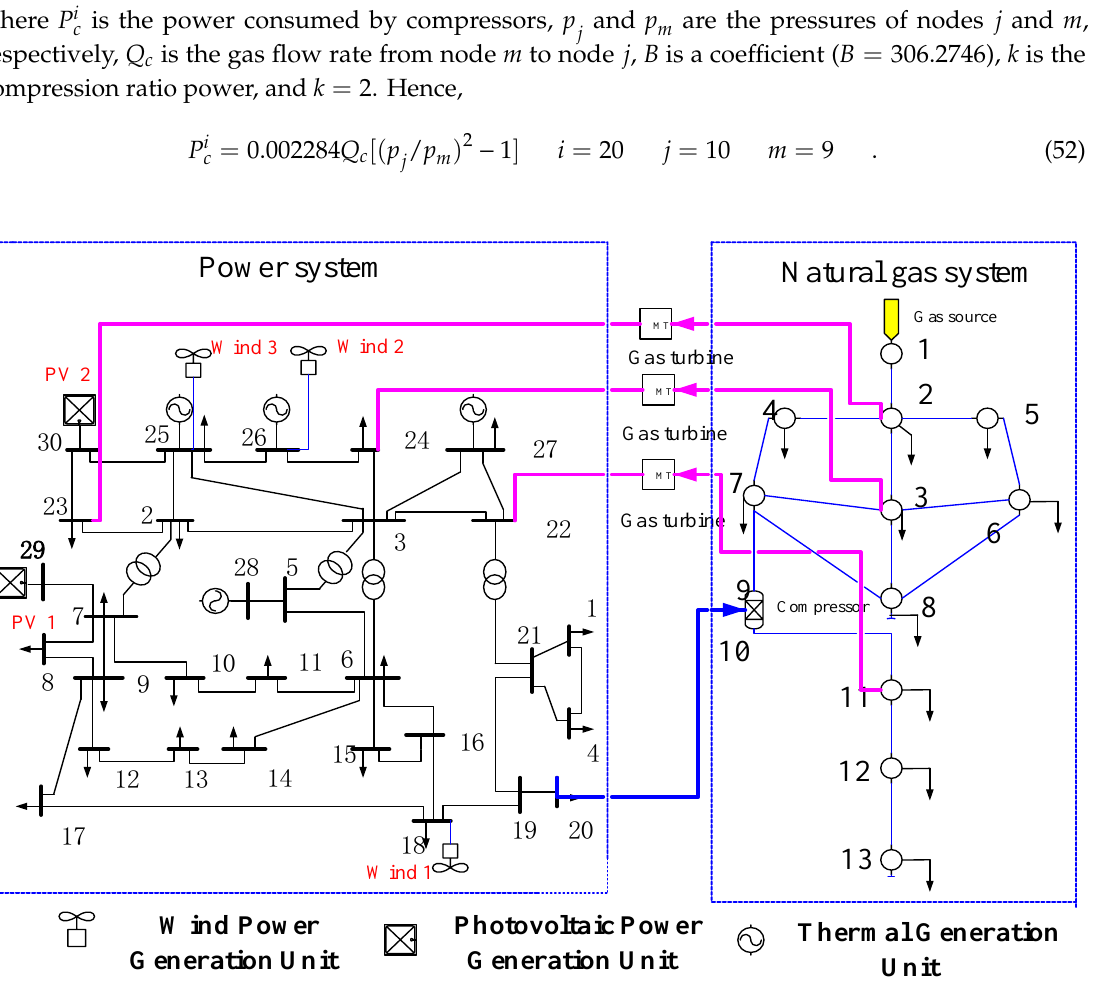
Figure 2. Diagram of the IES used in the case study.